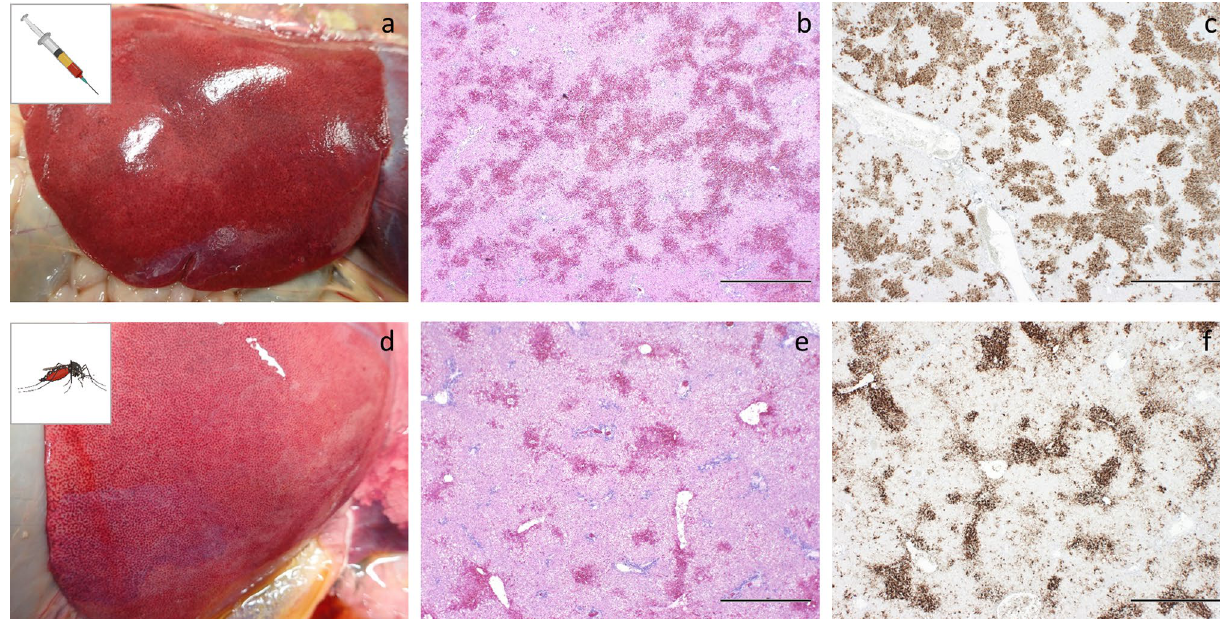
Figure 3. Representative pathology in lambs exposed to RVFV via IV-inoculation or infected mosquitoes. Panels a – c were obtained from lamb #161 (IV inoculation). Panels d – f were obtained from lamb #154 (mosquito exposure). Both lambs were euthanized after reaching a HEP. Swollen liver with mottled appearance indicative of hepatic degeneration/necrosis ( a , d ), H&E staining of liver sections showing multifocal to bridging necrosis of hepatocytes with haemorrhages ( b , e ). IHC staining of a liver section with mAb 4-D4 showing strong immunolabelling for RVF antigen of the areas with degeneration and necrosis of hepatocytes ( c , f ). Bar = 1,000